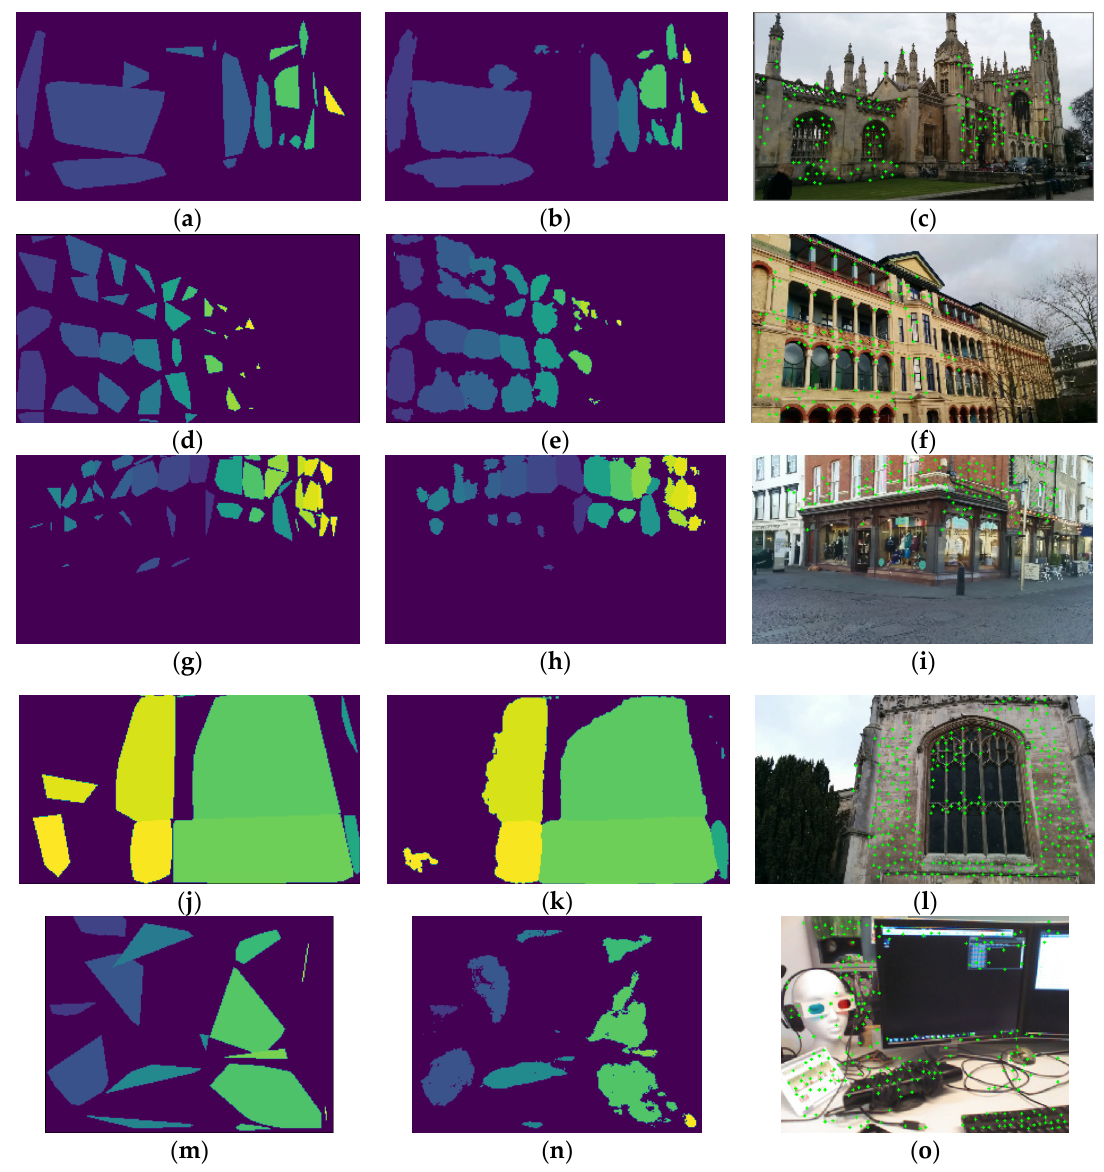
Figure 5. Illustration of the 2D–3D matching process with our voxel-based scene representation system: Voxel regions of inlier 3D points in ( a ) King’s College, ( d ) Old Hospital ( g ) Shop Façade, ( j ) St. Mary’s Church scenes, and ( m ) Heads; Voxel regions detected in ( b ) King’s College, ( e ) Old Hospital ( h ) Shop Façade, ( k ) St. Mary’s Church images, and ( n ) Heads; Interest points in detected voxel regions in ( c ) King’s College, ( f ) Old Hospital ( i ) Shop Façade, ( l ) St. Mary’s Church images, and ( o ) Heads.